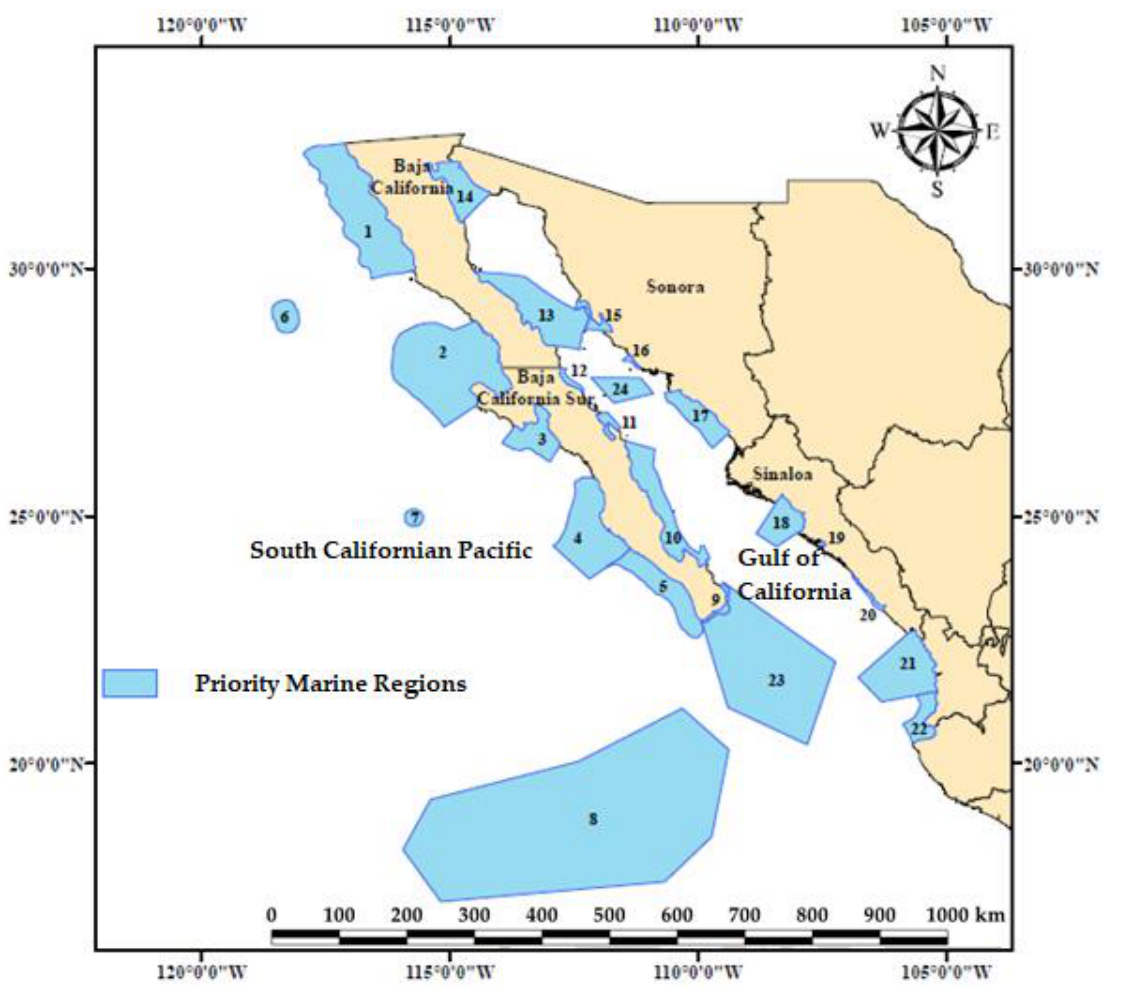
Figure 1. Map of the Priority Marine Regions (PMR) located in the Northwest of Mexico, where monthly Chlorophyll a (Chl a ) data were obtained for the environmental and oceanographic anal- yses.